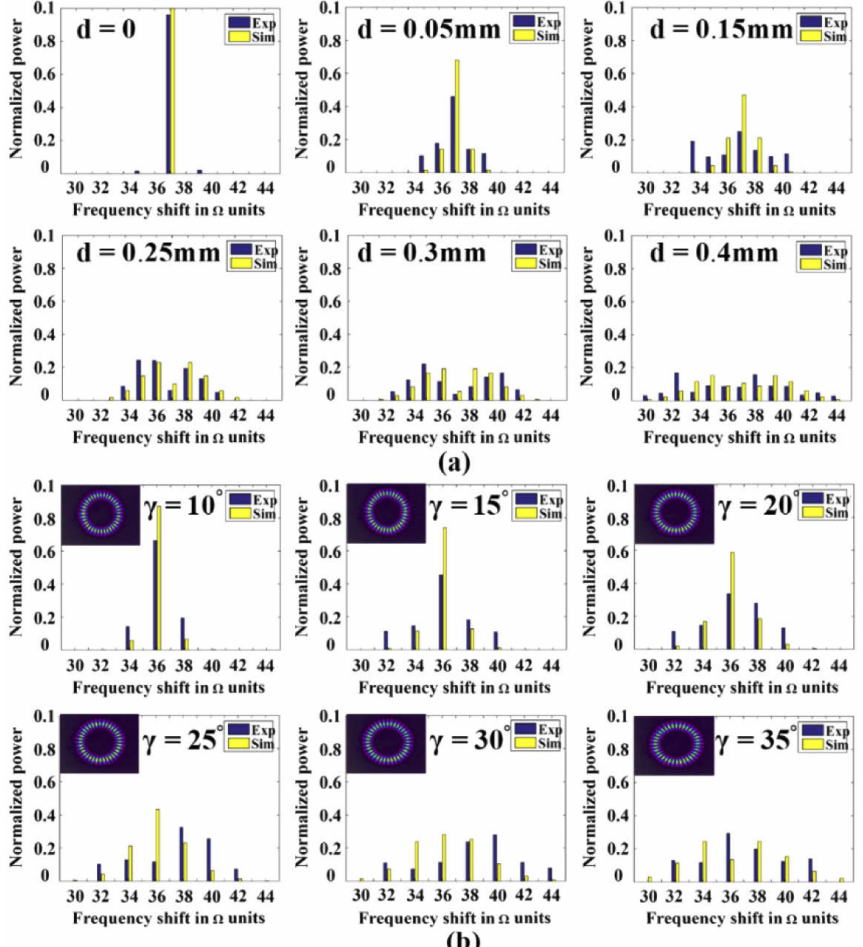
Figure 19. Modal distribution under ( a ) lateral misalignment and ( b ) angular deflection. Adapted with permission from ref.